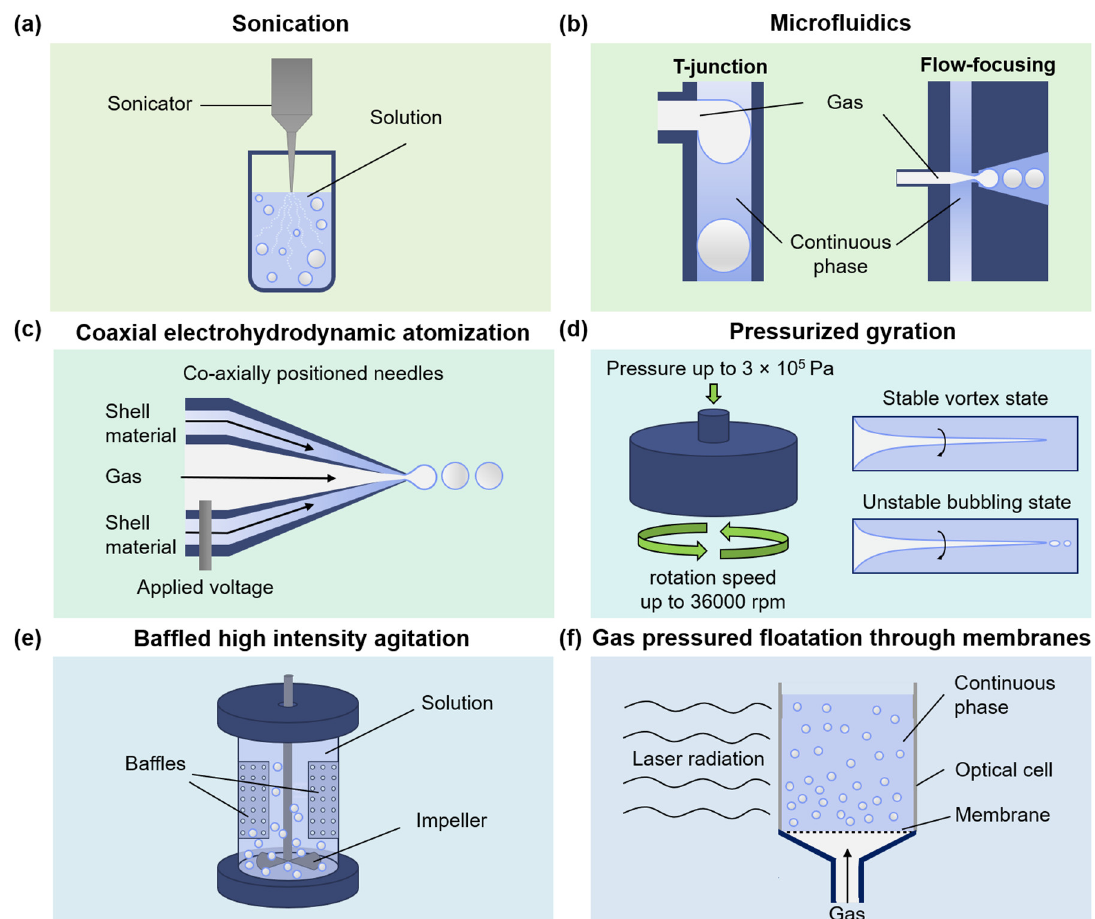
Figure 3. Strategies for protein MBs fabrication. ( a ) Sonication, ( b ) flow-focusing and T-junction mi- crofluidics, ( c ) coaxial electrohydrodynamic atomization (CEHDA), ( d ) pressurized gyration, ( e ) baffled high-intensity agitation (BHIA), and ( f ) gas-pressured floatation through membranes.